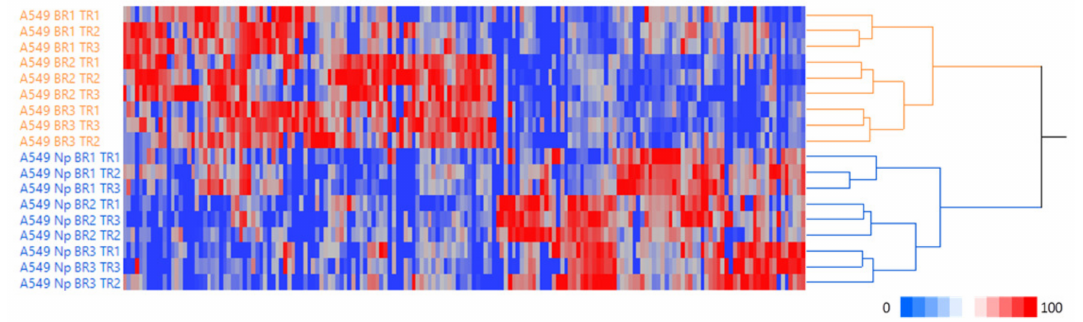
Figure 1. Hierarchical clustering of single protein lists from A549 cells transfected with an empty vector and with SARS-CoV-2 N protein. The dendogram was obtained by computing the peptide spectrum matches (PSMs) of statistically significant proteins selected by linear discriminant analysis (LDA); Euclidean’s distance metric and Ward’s methods were applied (JMP15.2 software). Categories were reported in different colours accordingly to the strain